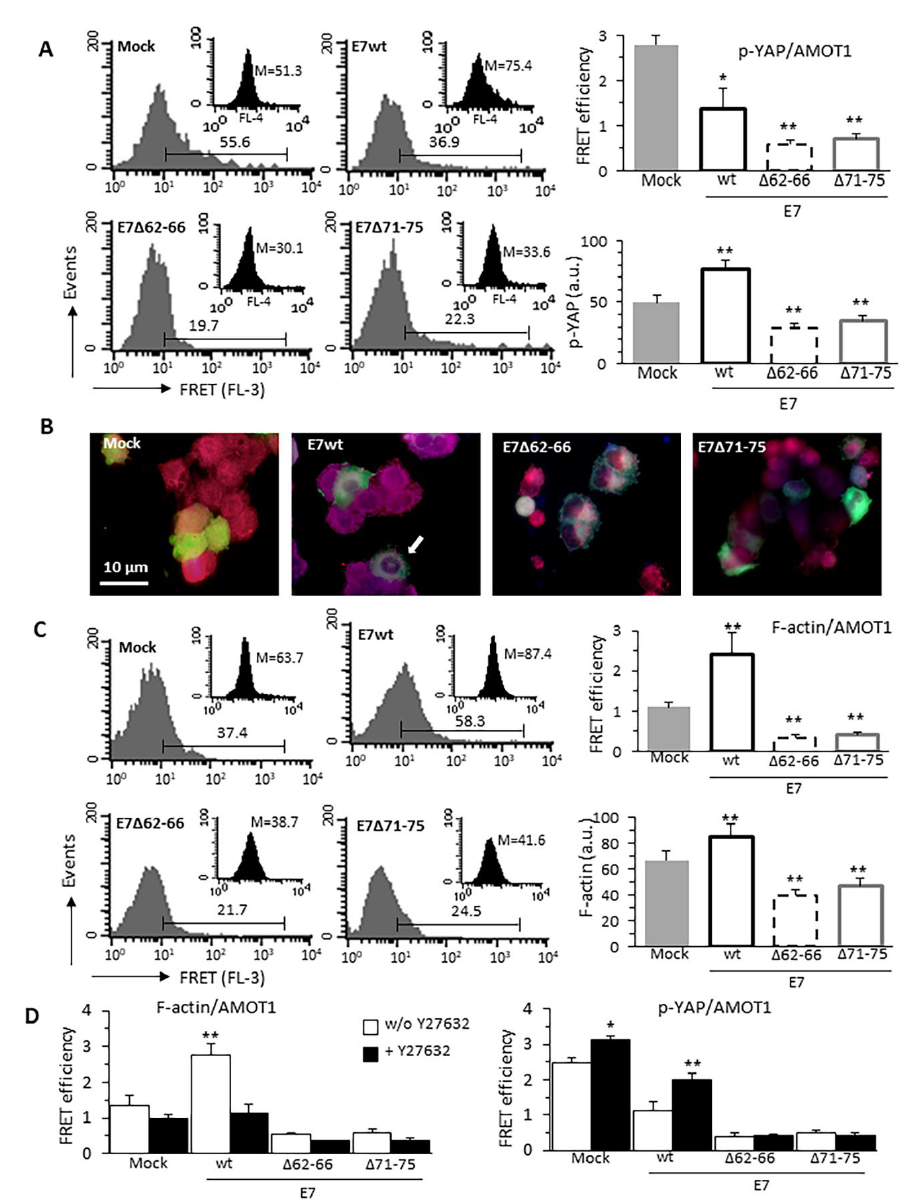
Figure 5. E7-induced F-actin alterations interfere with p-YAP/AMOT1 interactions. Quantitative evaluation of ( A ) p-YAP/AMOT1 and ( C ) F-actin/AMOT1 molecular association by FRET technique, as revealed by flow cytometry analysis restricted to pAmCyan-positive cells. Numbers indicate the percentage of FL3-positive events, obtained in one experiment representative of three. Bar graphs on right show FRET efficiency calculated according to the Riemann's algorithm. Data are reported as mean ± SD from three independent experiments. Inset: representative flow cytometry histograms of p-YAP expression ( A ) or F-actin amount ( C ) in the corresponding sample. Numbers indicate the median fluorescence intensity. Bar graphs on the bottom right represent the mean ± SD of the median fluorescence intensity values obtained in three different experiments. * p < 0.05 and ** p < 0.01 vs. Mock transfected cells. ( B ) IVM analysis after double cell staining with anti-p-YAP (blue) and anti-AMOT antibody (red) of cells transfected (green) with pAmCyan empty vector (Mock), E7 wild-type (E7wt) or deletion mutant constructs E7 ∆ 62–66, E7 ∆ 71–75. To note that p-YAP/AMOT complexes appeared markedly distributed in the perinuclear area of E7wt cells while were reduced and scattered in the cytoplasm of mutant cells (see arrow); ( D ) Bar graphs showing F-actin/AMOT1 (left) and p-YAP/AMOT1 (right) molecular association observed in different samples treated or not with the RhoGTPase inhibitor Y27632 and quantified as FRET efficiency. Analysis was restricted to pAmCyan-positive cells. Data are reported as mean ± SD from three independent